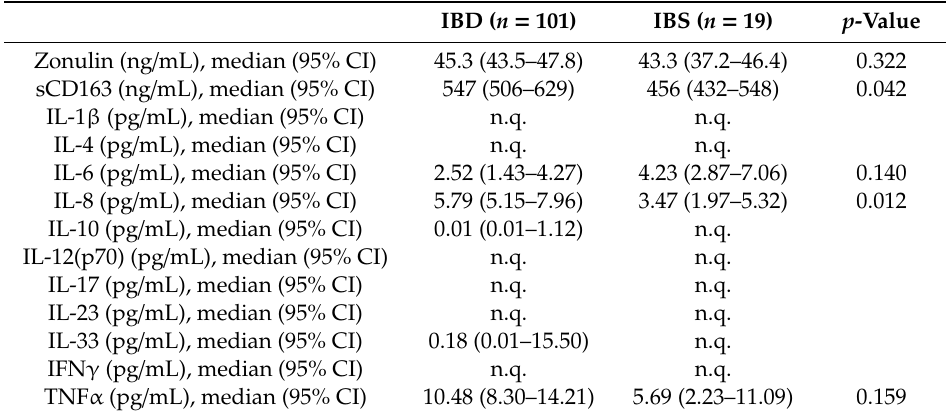
Table 2. Comparison of zonulin, sCD163, and cytokine levels at baseline between patients with IBD and those with IBS.